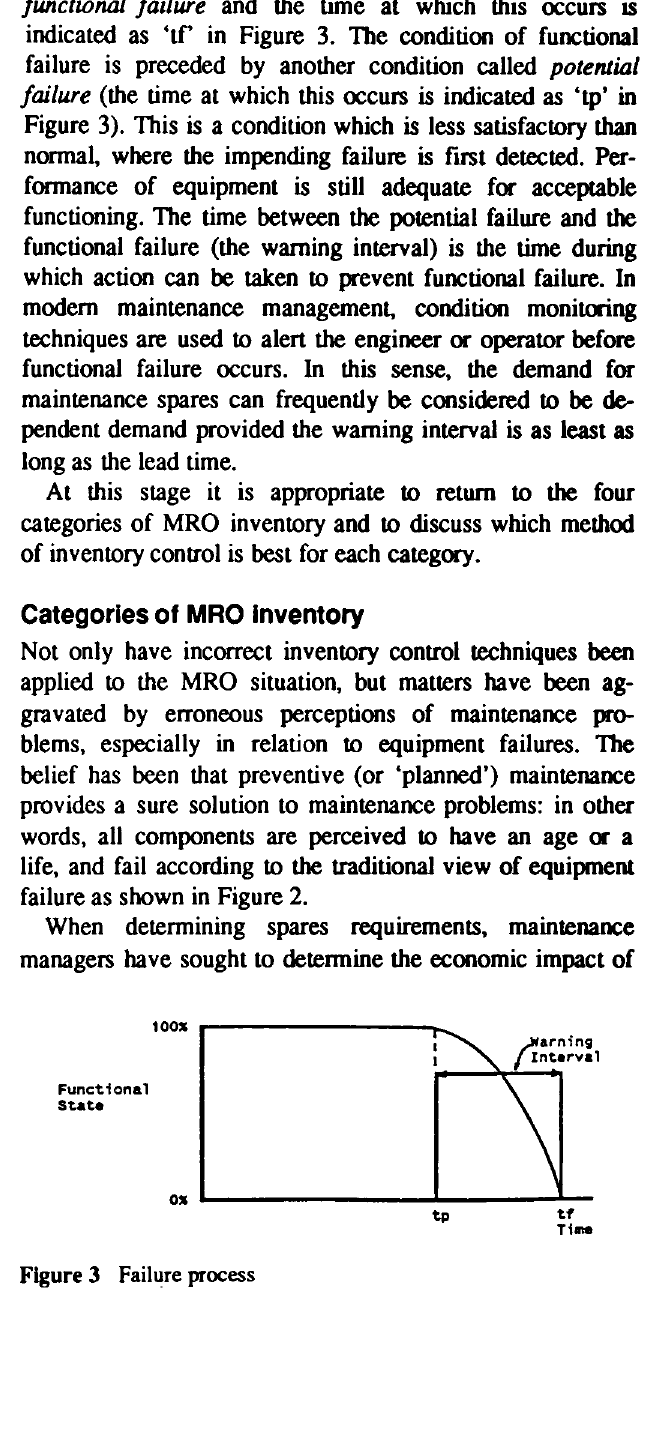
Figure 1 Cyclical demand for spares